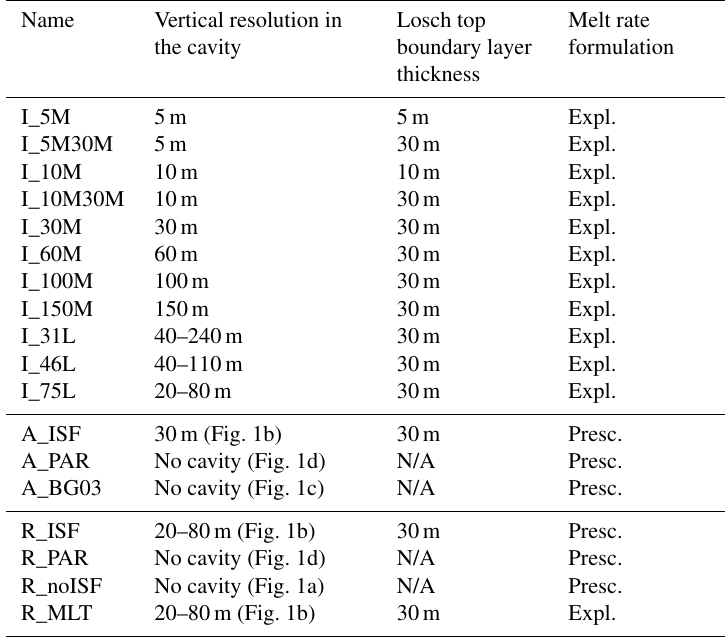
Table 2. List of model runs. Expl. means the ice shelf melt rate is explicitly calculated. Presc. means the ice shelf melt rate is prescribed (i.e. independent of ocean temperature and salinity and constant in